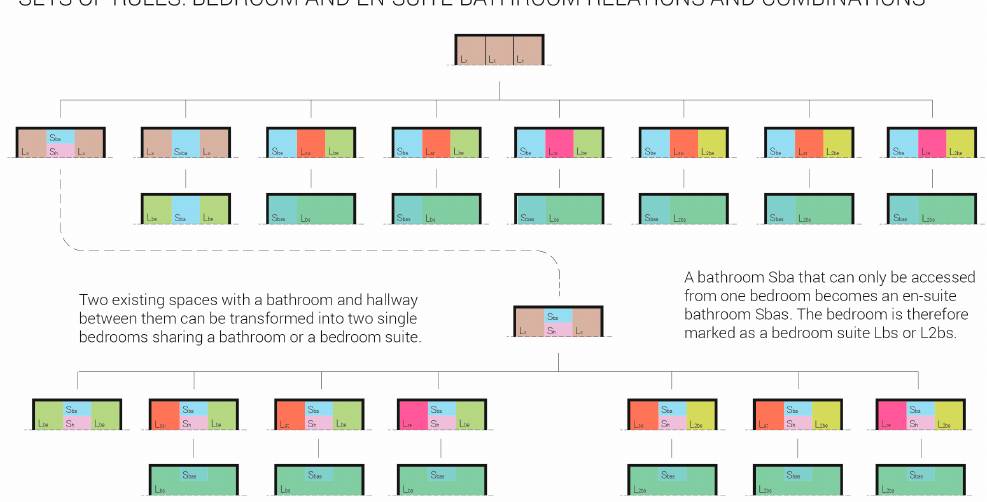
Figure 19. Sets of rules that can be employed to transform three adjacent rooms into bedroom suites (Ana Bel č i č , 2022).